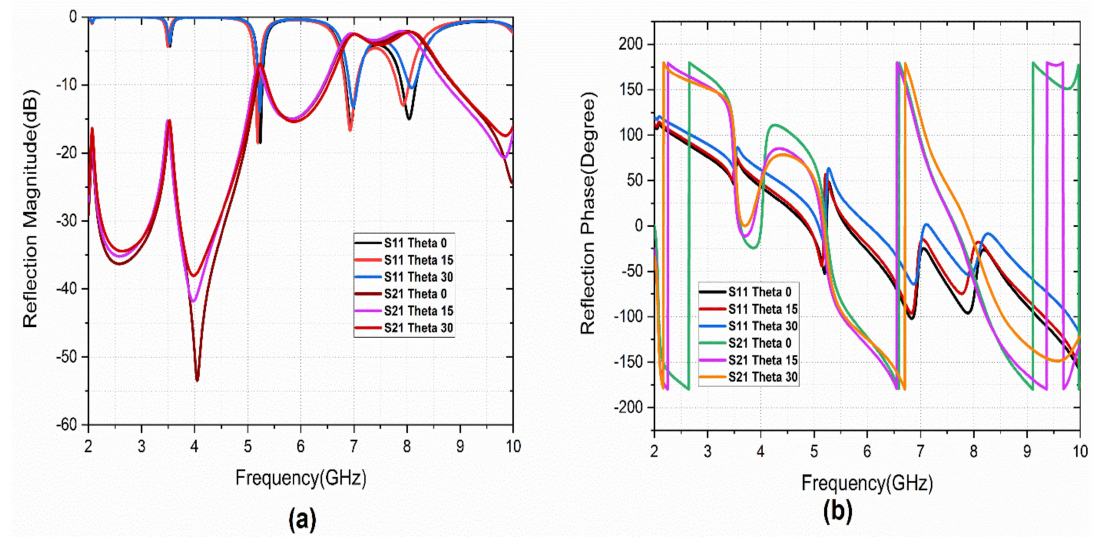
Figure 8. Reflection characteristics under TE incident angle variation: ( a ) magnitude, ( b ) phase.